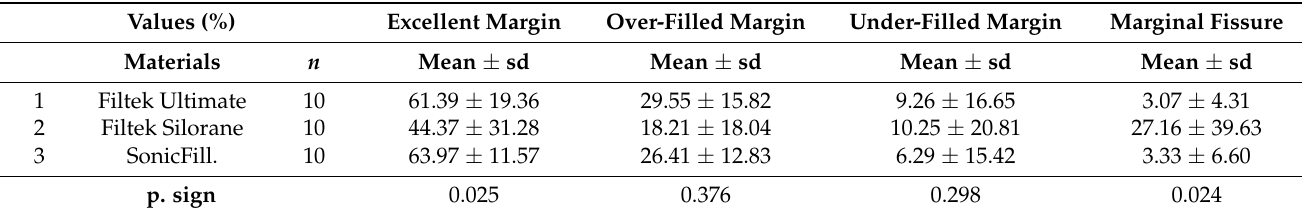
Table 4. Marginal adaptation to the lingual proximal